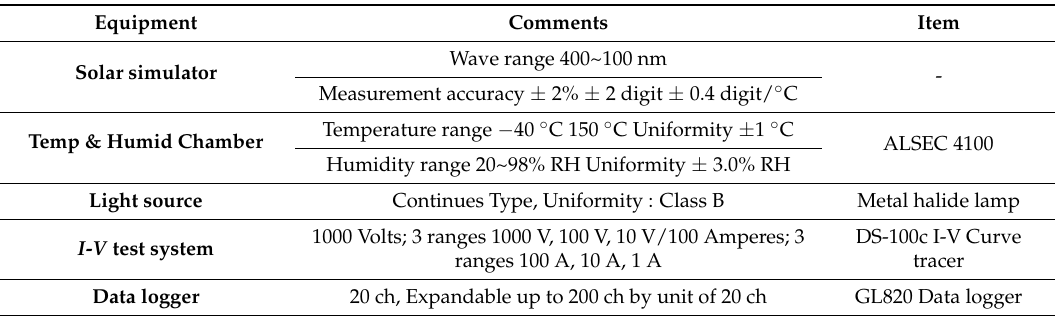
Table 3. Specification of the measurement